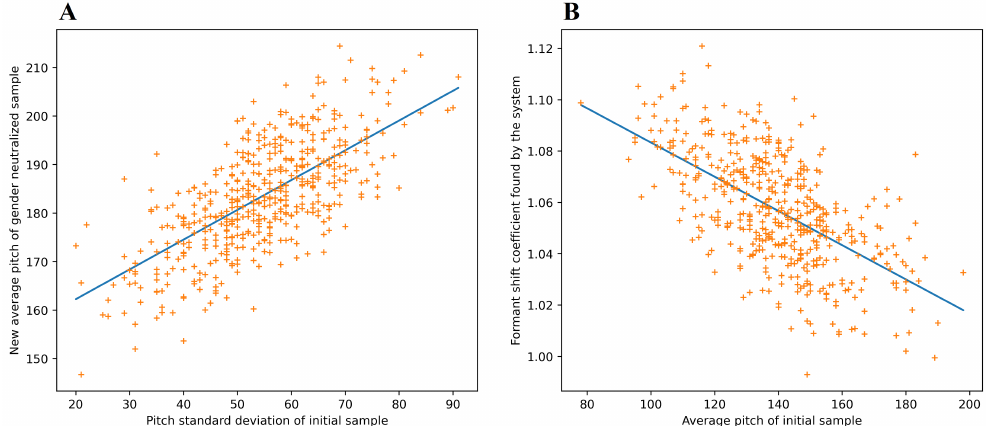
Figure 4. Correlation of initial sound features and correct transformation parameters for gender neutralization for male samples. Orange ‘+’ markers correspond to each sound sample and blue line is representing equation of corresponding correlation. ( A ) Correlation of initial pitch standard deviation and new pitch value of neutralized sound. ( B ) Correlation of initial average pitch to the formant shift coefficient in neutralized